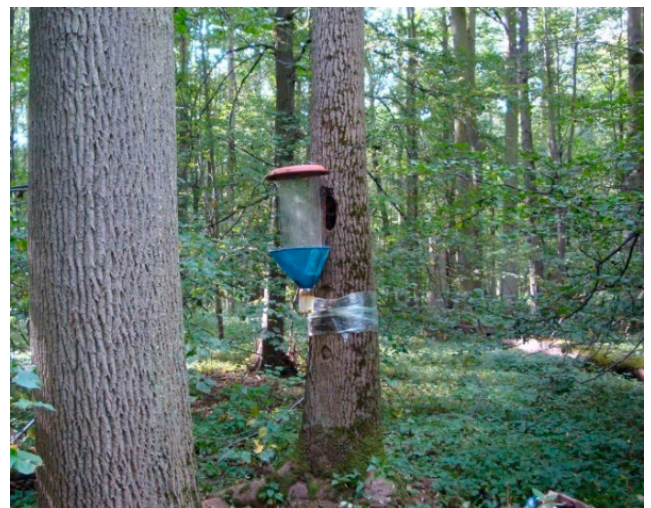
Figure 2. Trap in entrance to an ash tree cavity .